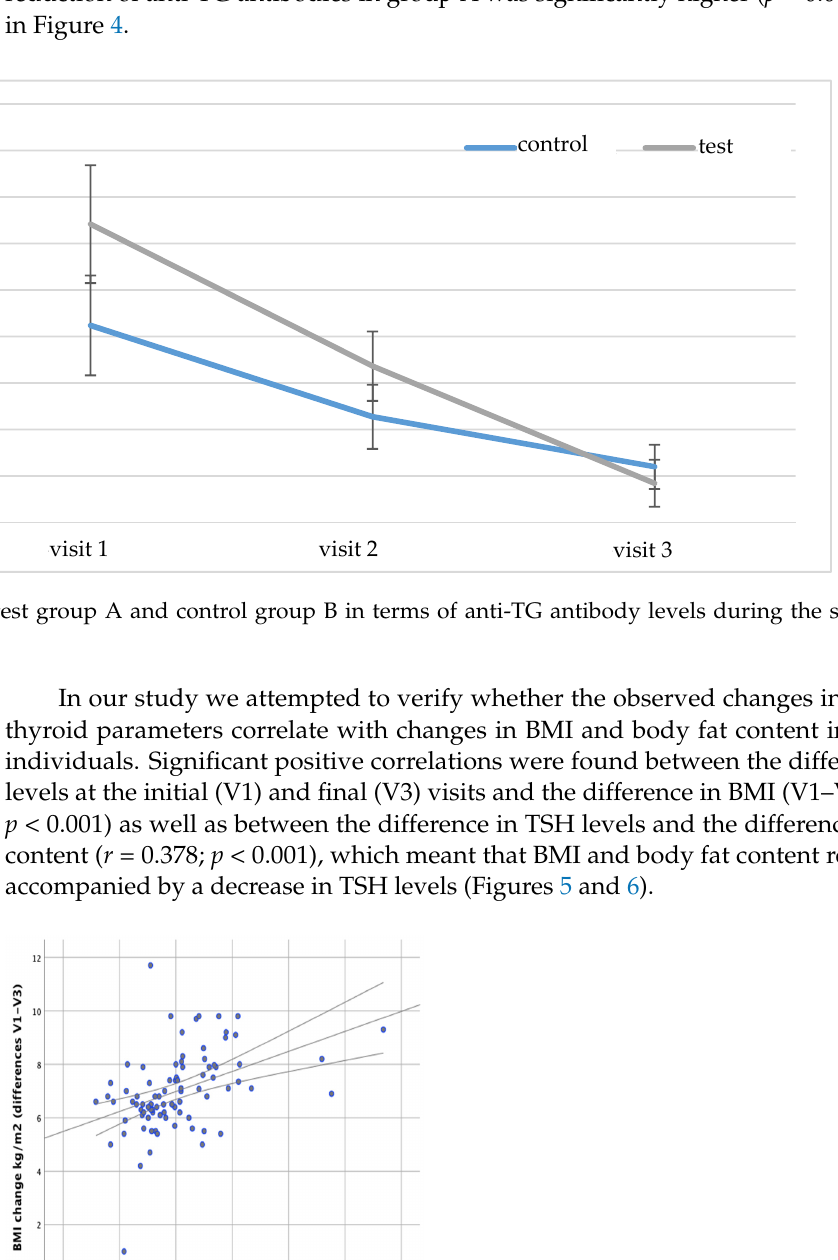
Figure 6. Correlations between changes in body fat content and differences in serum TSH levels (between initial visit V1 and final visit V3).